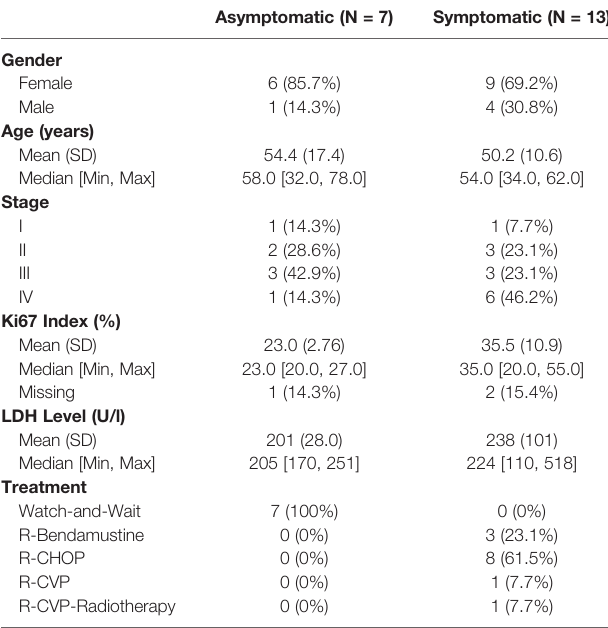
TABLE 1 | Clinicopathological characteristics of the FL